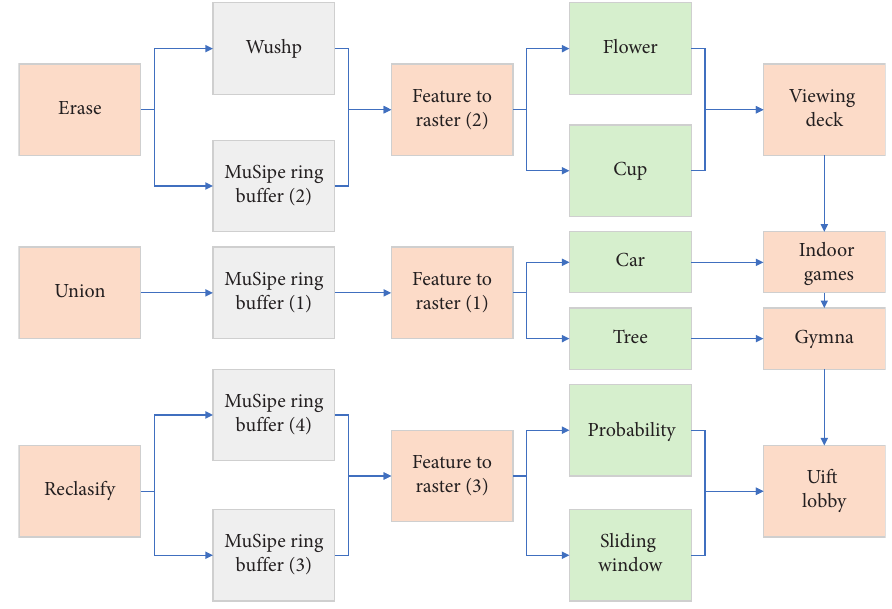
Figure 2: Landscape image features recognition